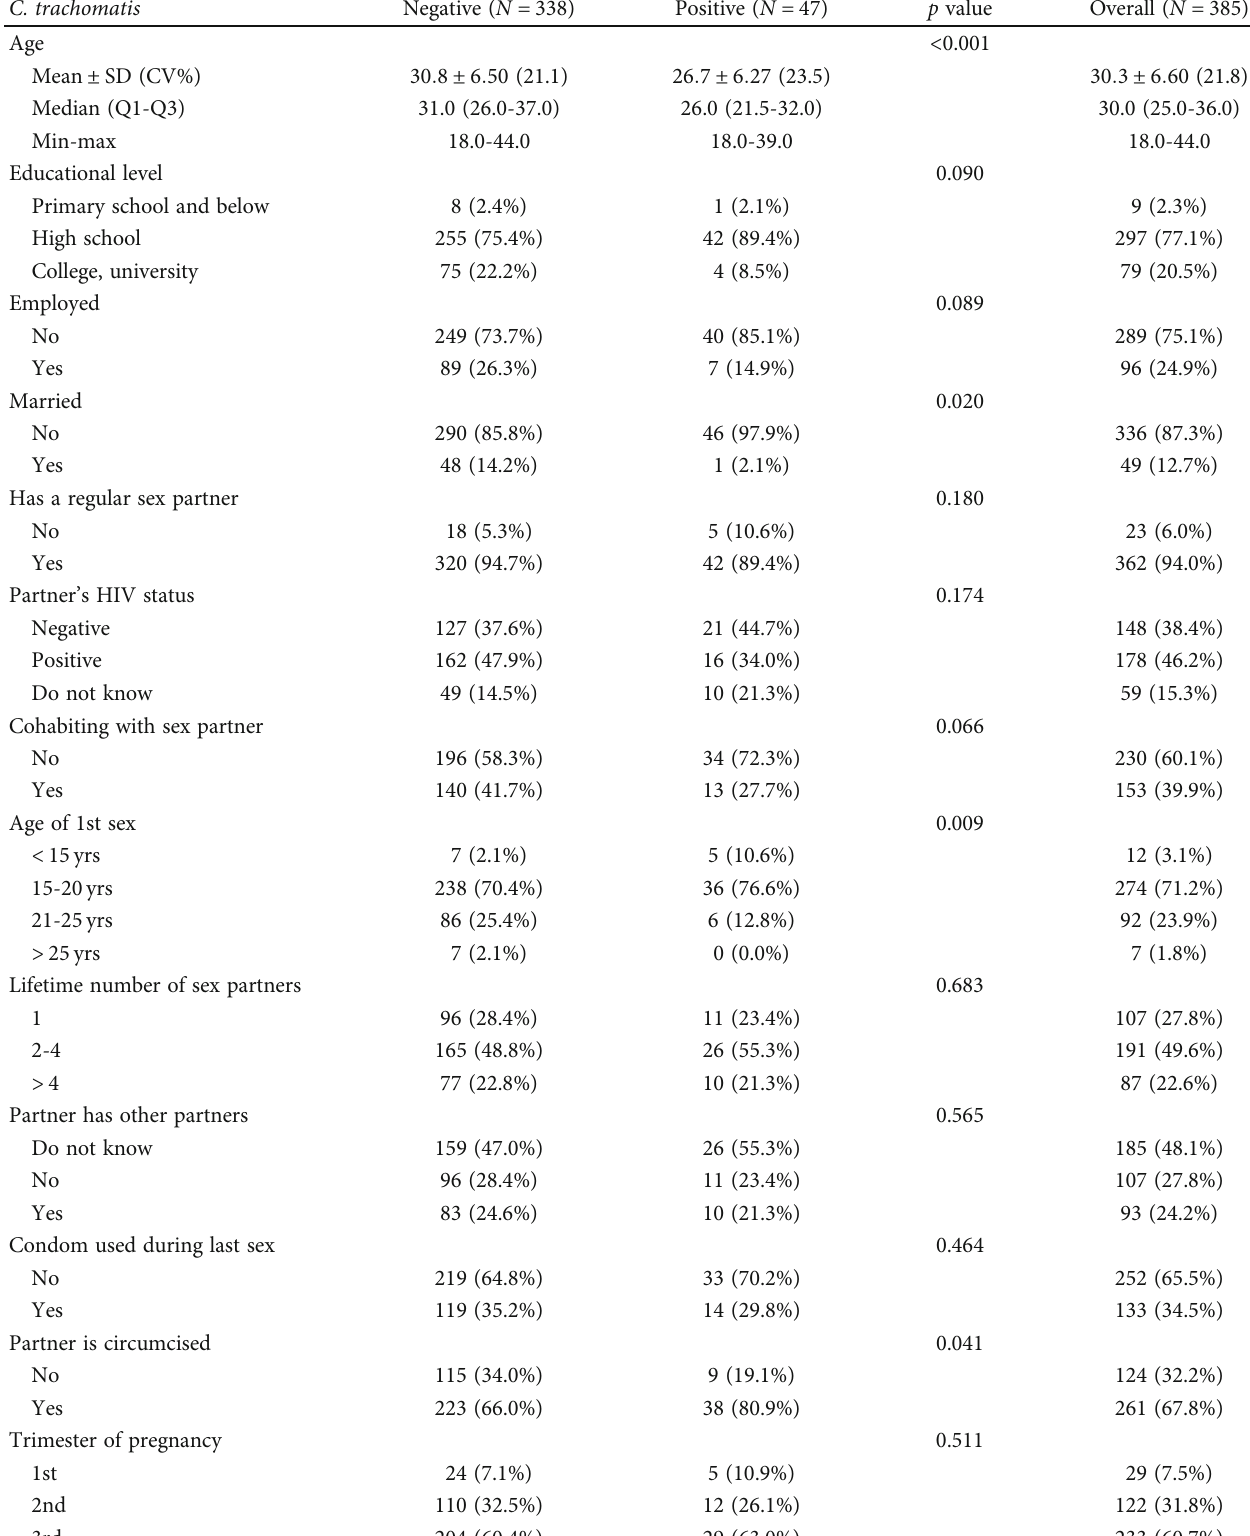
Table 1: Characteristics of the study population based on C. trachomatis